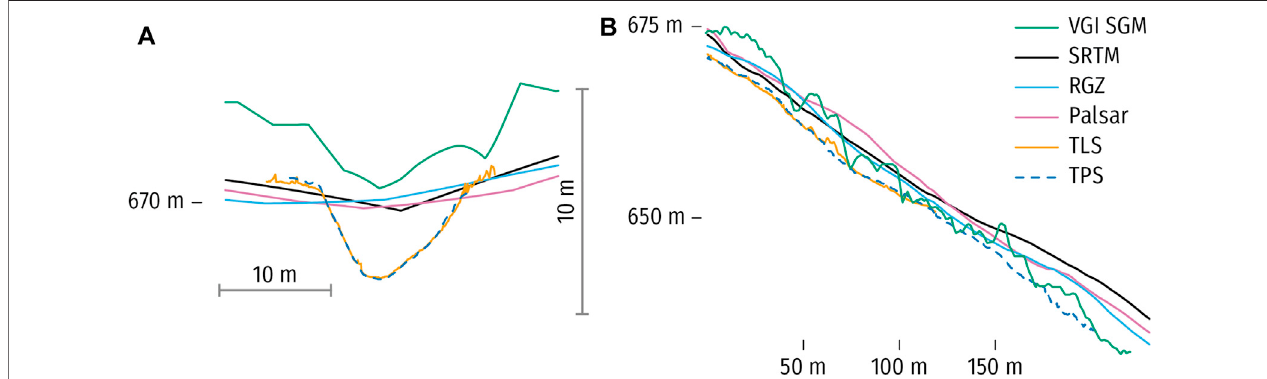
Frontiers in Environmental Science |